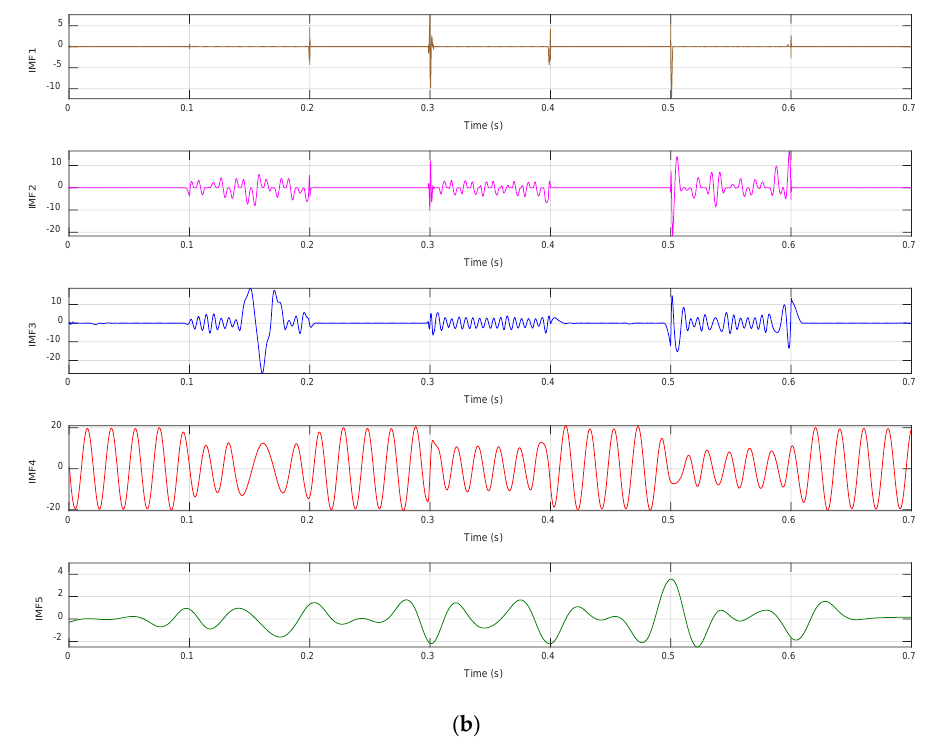
Figure 7. Direct-axis current and its five intrinsic mode functions (IMFs). ( a ) Direct-axis component of five-phase fundamental currents with three different OCFs in the generator. ( b ) Five IMFs of the direct-axis current.